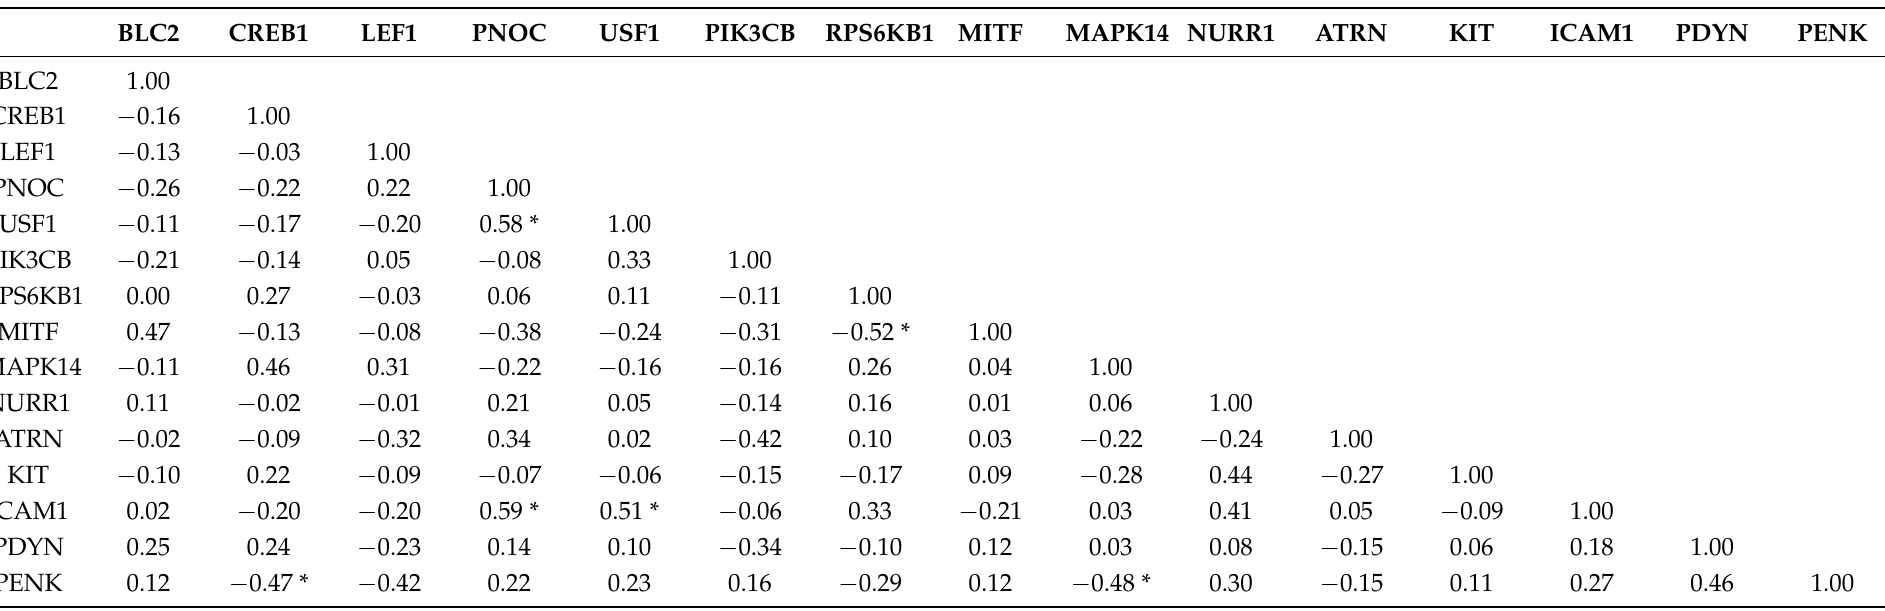
Table 1. Results of correlation analysis of gene expression in lesional skin biopsies of psoriasis patients. Spearman rank correlation coefficient (Spearman r) was used; * p <